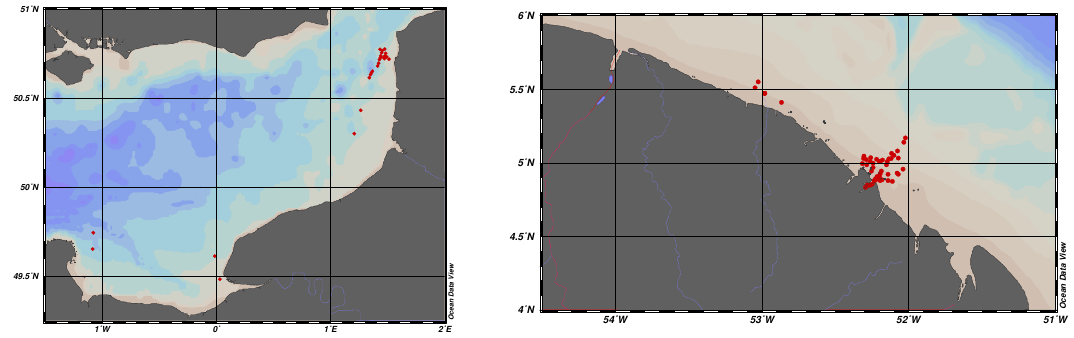
Figure 1. Maps of field OCR measurements locations over the Eastern English Channel ( left ) and French Guiana ( right ).